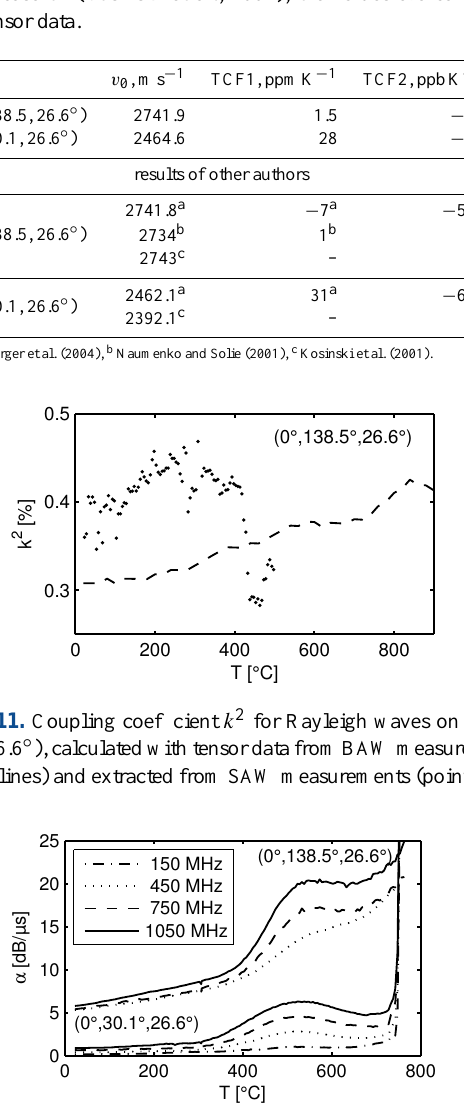
Figure 12. The propagation loss in [dB/µs] of Rayleigh waves on free surface on both cuts (0, 138.5, 26.6 ◦ ) and (0, 30.1, 26.6 ◦ ), mea- sured at different